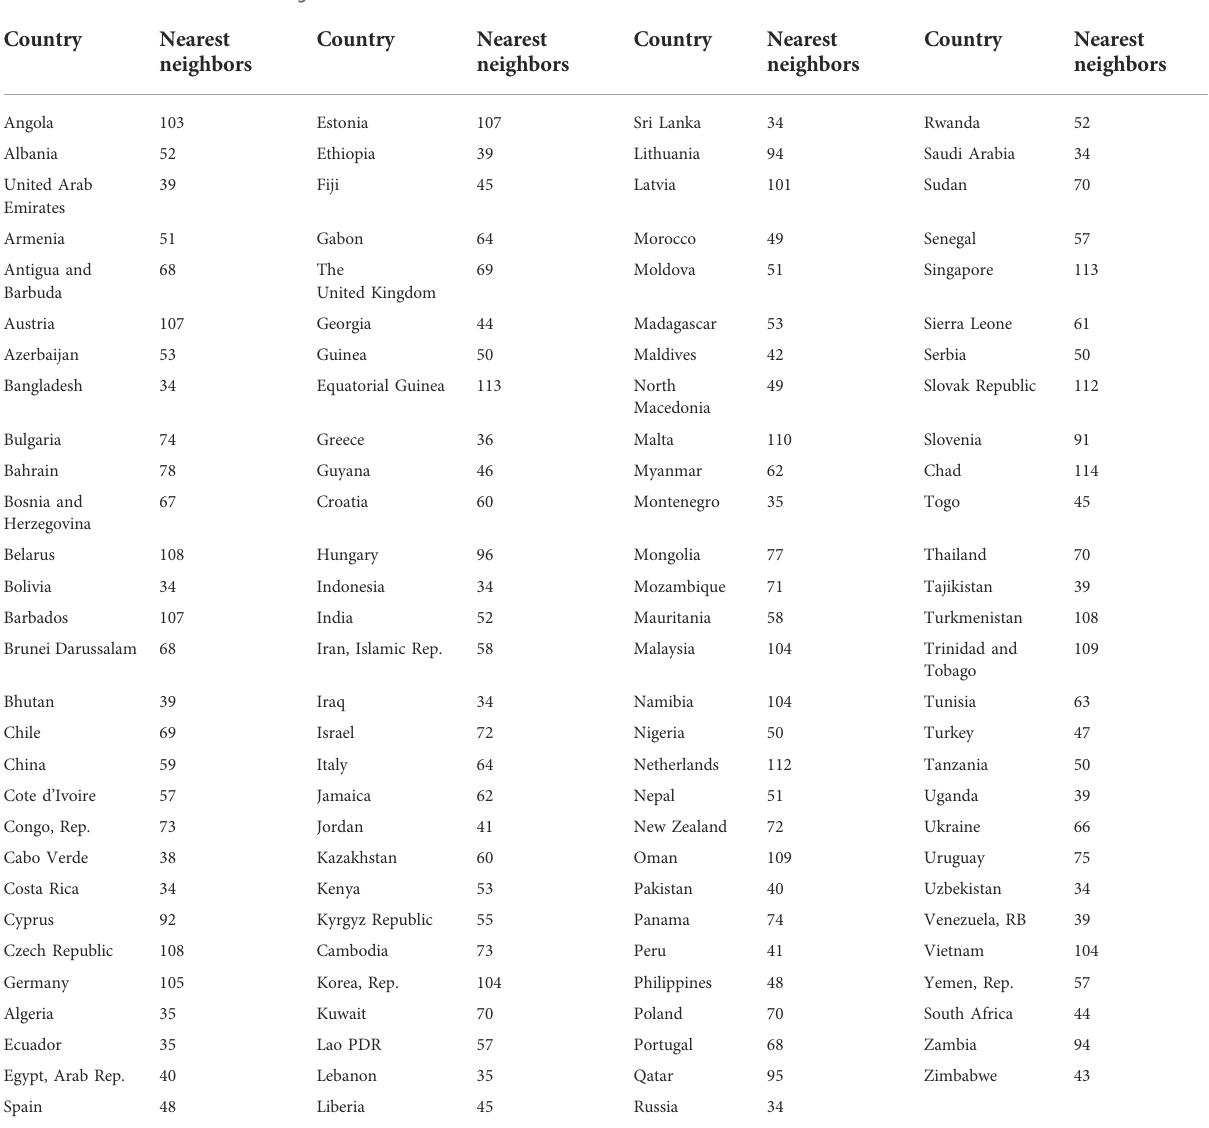
TABLE 3 The number of nearest